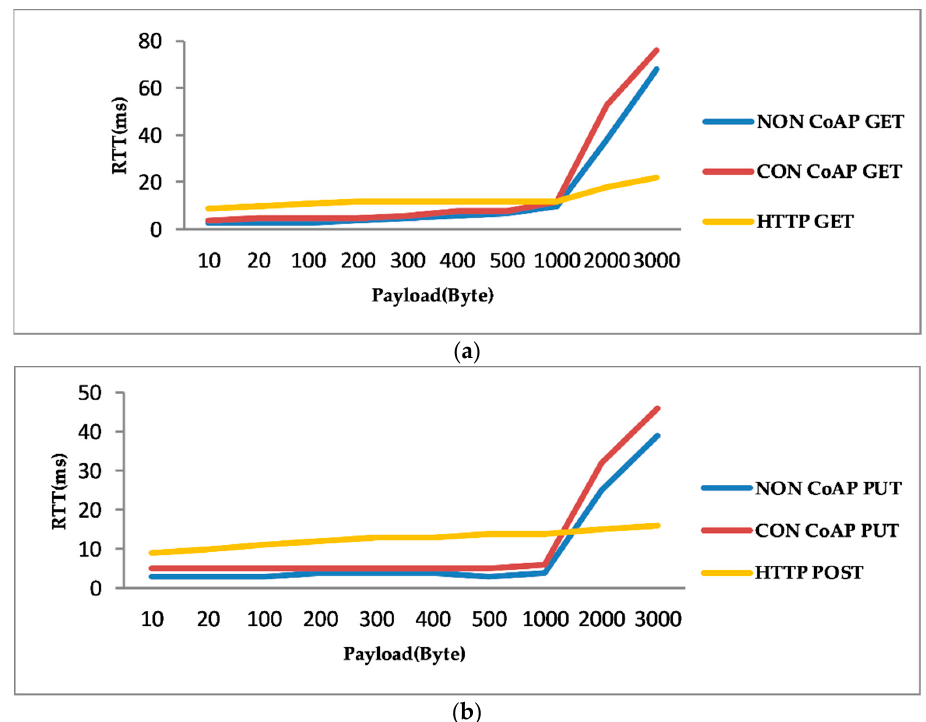
Figure 8. CoAP vs. HTTP: ( a ) CoAP GET and HTTP GET; and ( b ) CoAP PUT and HTTP POST.